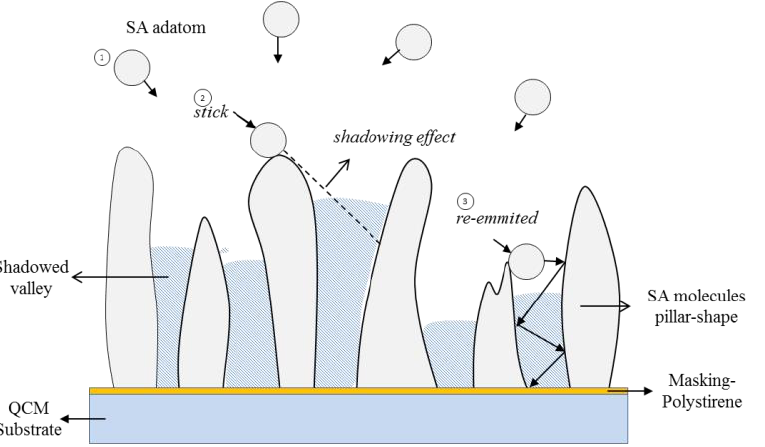
Figure 6. The physical reactions and mechanisms during the deposition control the layer ’ s morpho- logical change.